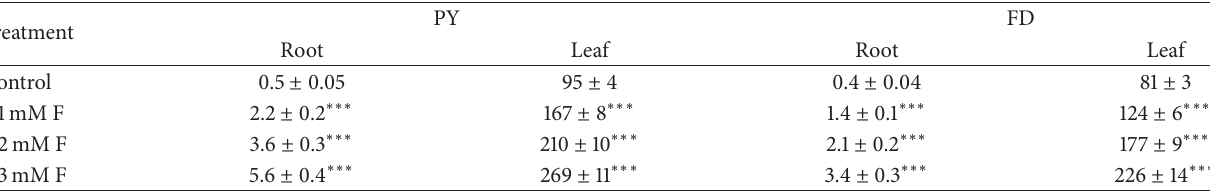
Table 2: Fluoride (F) accumulation in roots and leaves of PY and FD after 2-week fluoride treatments (mgkg − 1 DM). Data are expressed as means ± SD ( 𝑛 = 4 ). PY FD Treatment Root Leaf Root Leaf Control 0.5 ± 0.05 95 ± 4 0.4 ±